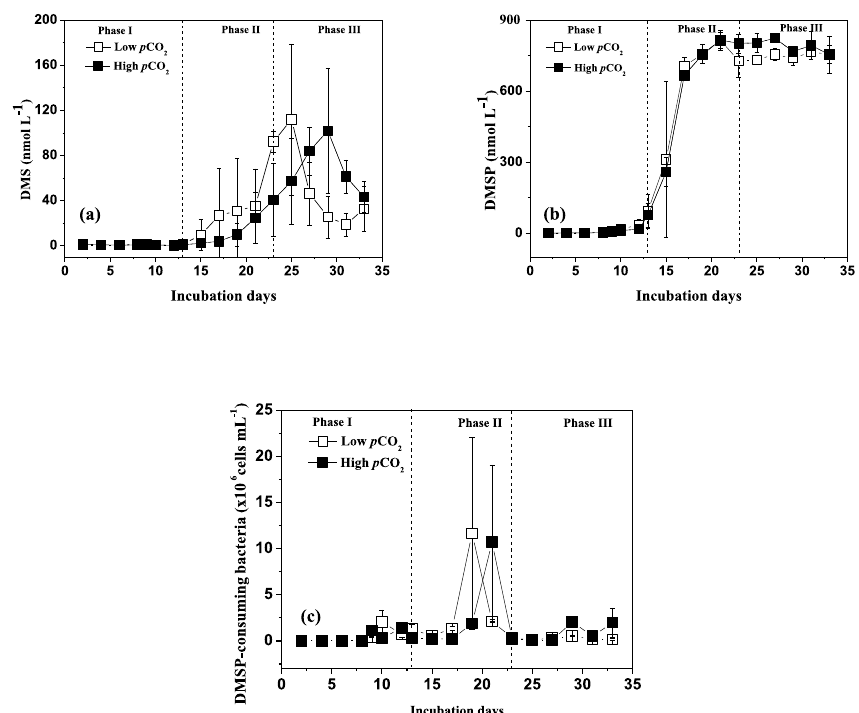
Figure 2. Temporal development in dimethylsulfide (DMS), dimethylsulfoniopropionate (DMSP) and DMSP-consuming bacteria concen- trations in the high p CO 2 (1000µatm, black squares) and low p CO 2 (400µatm, white squares) mesocosms. Data are mean ± SD, n = 3 (triplicate independent mesocosm